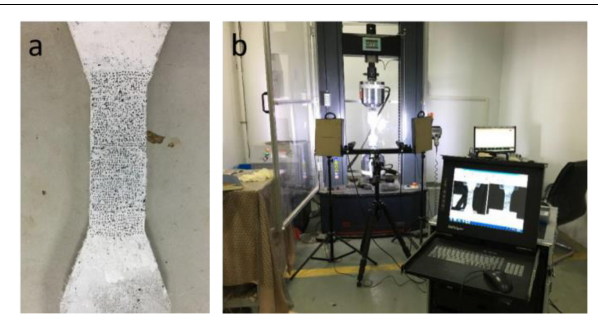
FIGURE 2 | Images of (a) specimen prepared for VIC-3D test and (b) the non-contact full-field 3D strain measurement